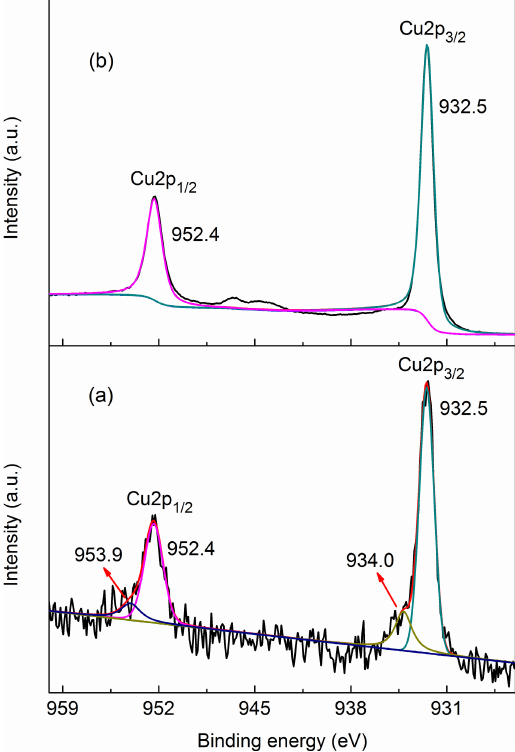
Figure 4: XPS high resolution spectra of Cu2p core level region for Cu 2 O films fabricated by different methods, (a) MOD, (b) self- oxidation